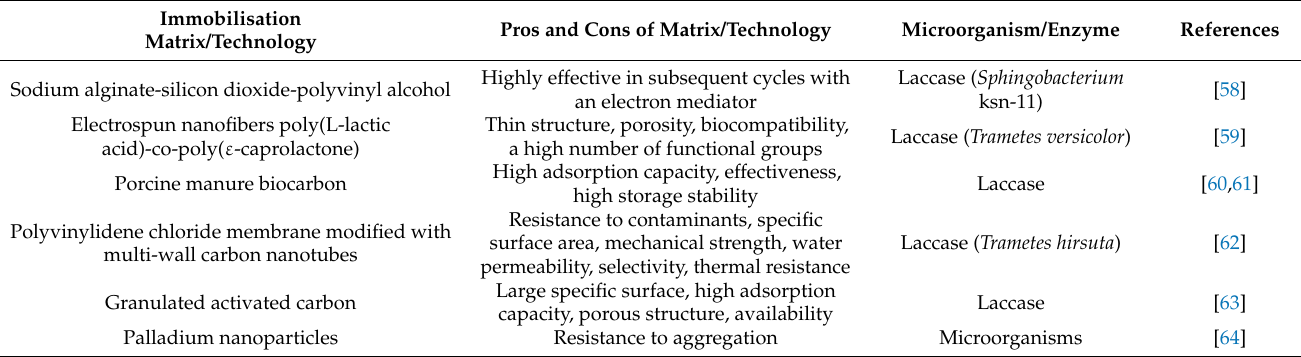
Table 3. Immobilisation matrix/technologies in diclofenac